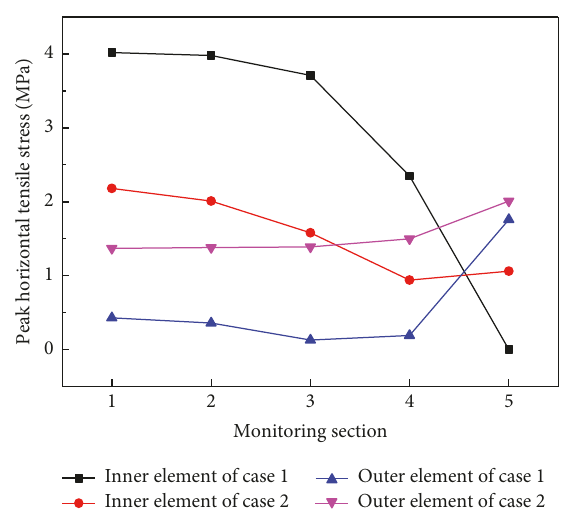
Figure 19: Peak horizontal tensile stress of monitoring sections for roof in 2